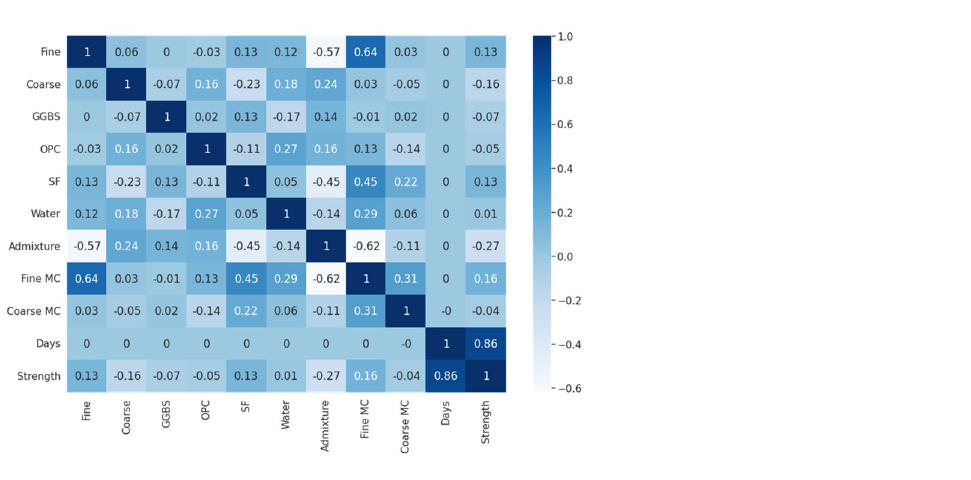
Figure 5. Pearson’s correlation